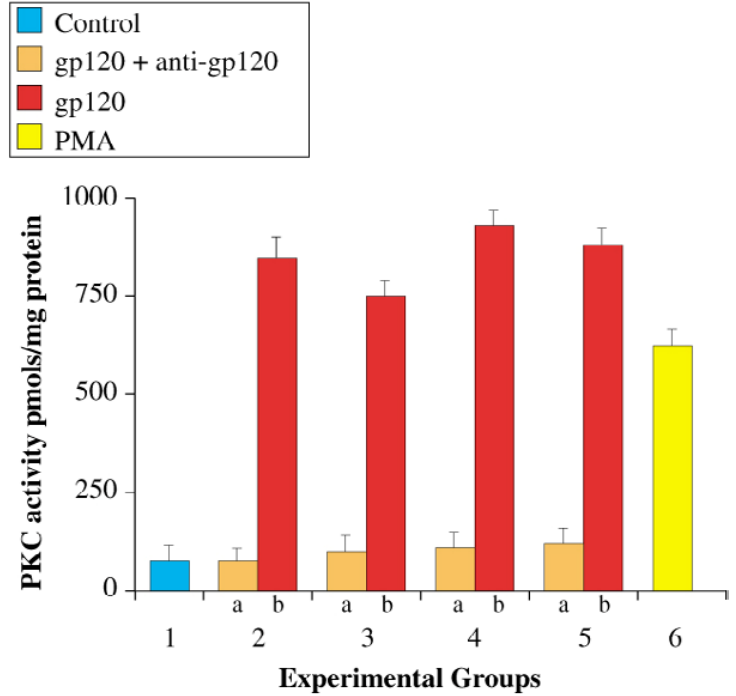
Figure 3. Effect of stimulation of astrocytes with gp120 and PMA on PKC enzymes. PMA or baculovirus system–expressed r-gp120 with or without polyclonal antibody to gp120 was applied to astrocytes in culture. PKC was assayed in the supernatant of cell homogenate, which had been centrifuged at 10,000 g. Induction of PKC by PMA was significantly less than by r-gp120 (p<0.05). Sheep anti-gp120 (1:20) effectively blocked the activity of r-gp120.